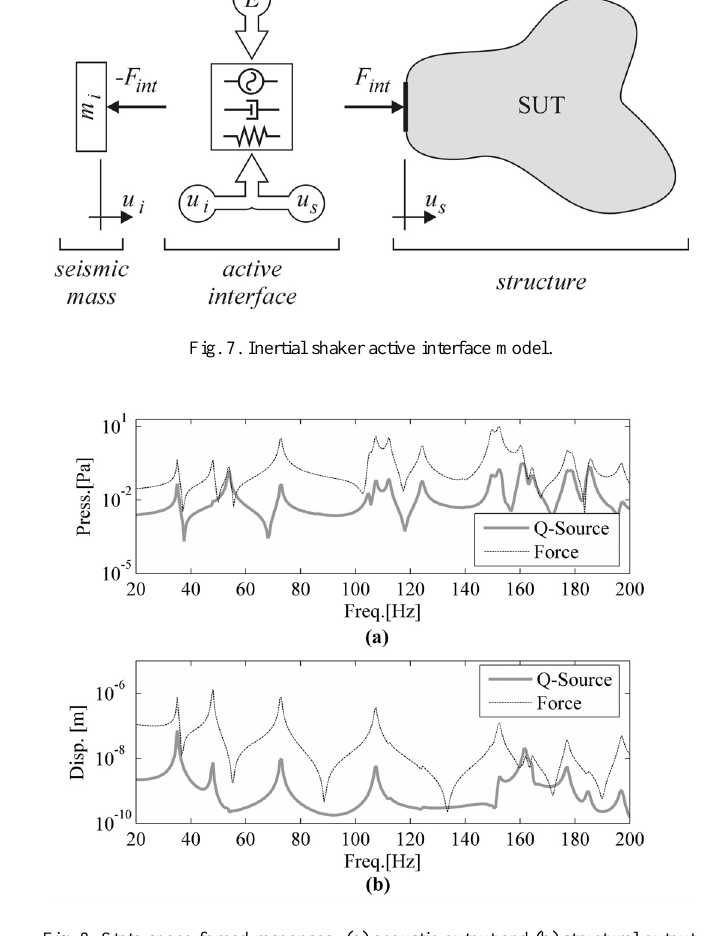
Fig. 8. State-space forced responses: (a) acoustic output and (b) structural